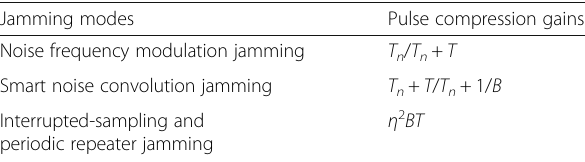
Table 1 The pulse compression gains of different